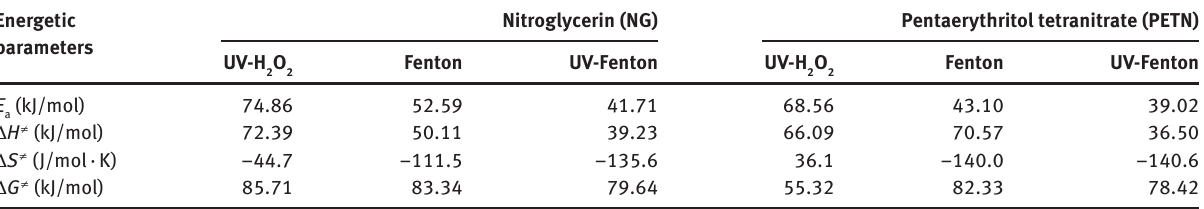
Table 3: Activation energies and energetic parameters for the degradation of NG or PETN using different AOPs. Energetic parameters